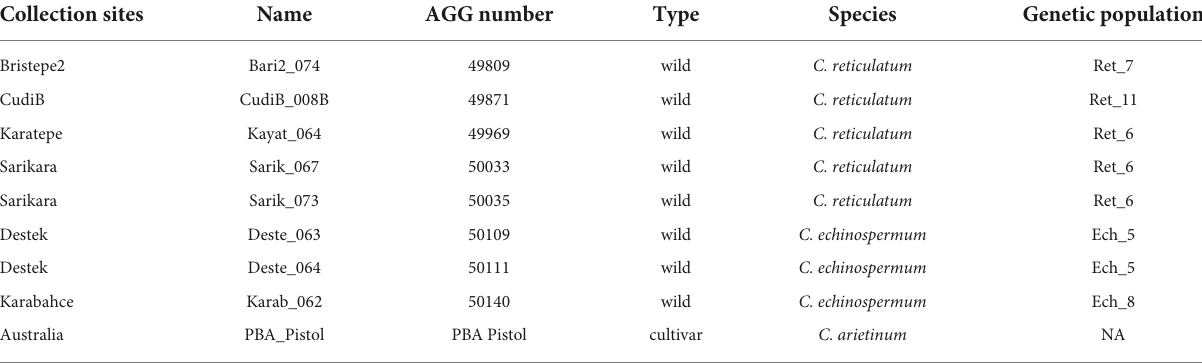
TABLE 1 Background information for chickpea